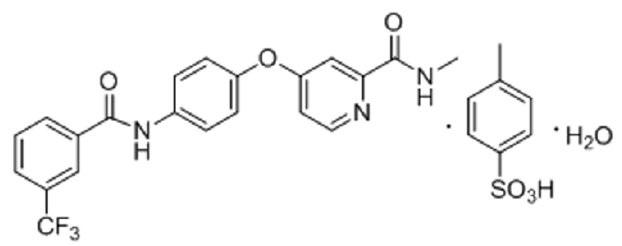
Figure 1. Chemical structure of